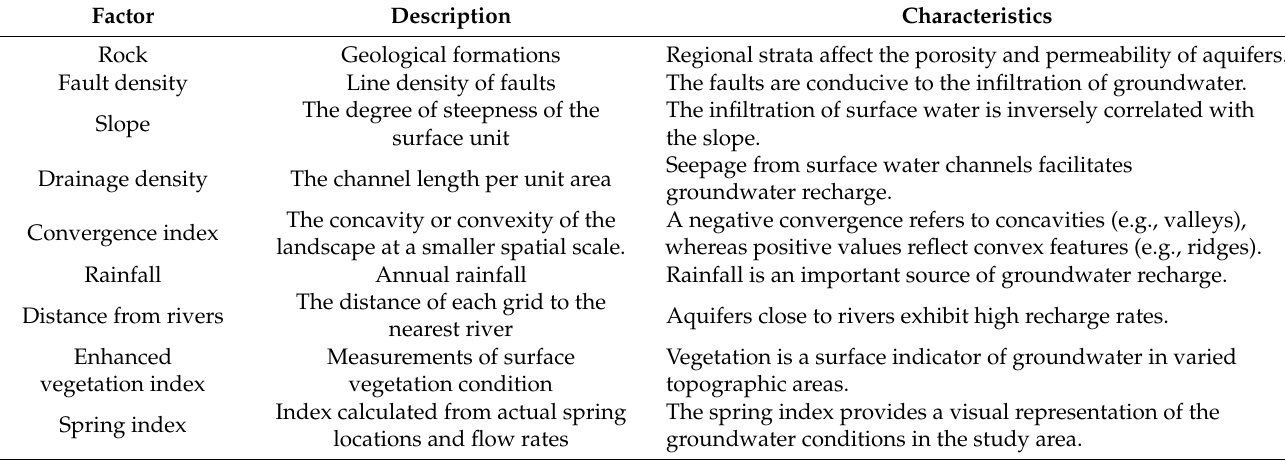
Table 4. Description of groundwater potential assessment factors.